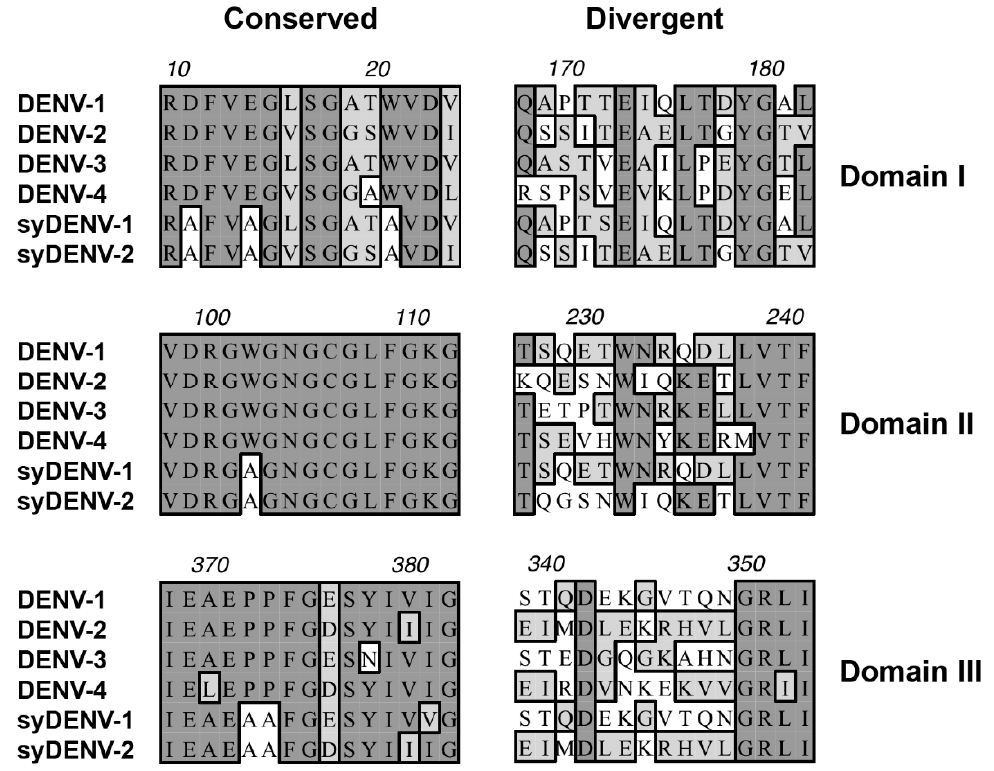
Figure 1. Linear cross-reacting and serotype-specific epitopes within the sequence of the DENV E protein. Examples of cross-reacting epitopes located across the three domains of the DENV E protein show highly homologous amino acid sequences shared by all four serotypes of DENV (Conserved column on the left). Proline, aromatic, and/or charged amino acid residues within these cross-reacting epitopes were substituted for alanine in synthetic DNA sequences of the mutant E proteins (the empty boxes around As in syDENV protein sequences). The sequences of serotype-specific epitopes (Divergent column on the right) remained unmodified in the synthetic protein sequences.